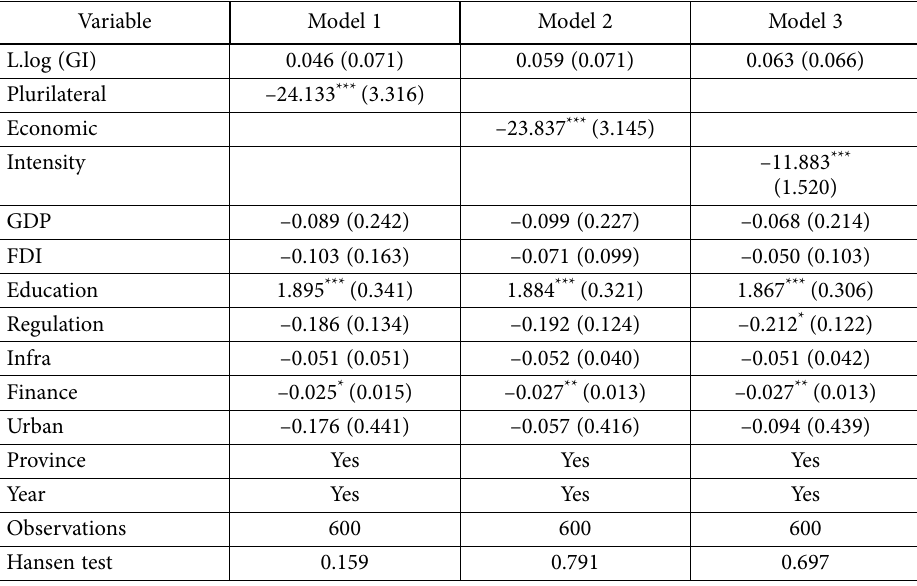
Table 5. Estimation results of the GMM model for adding omitted variables